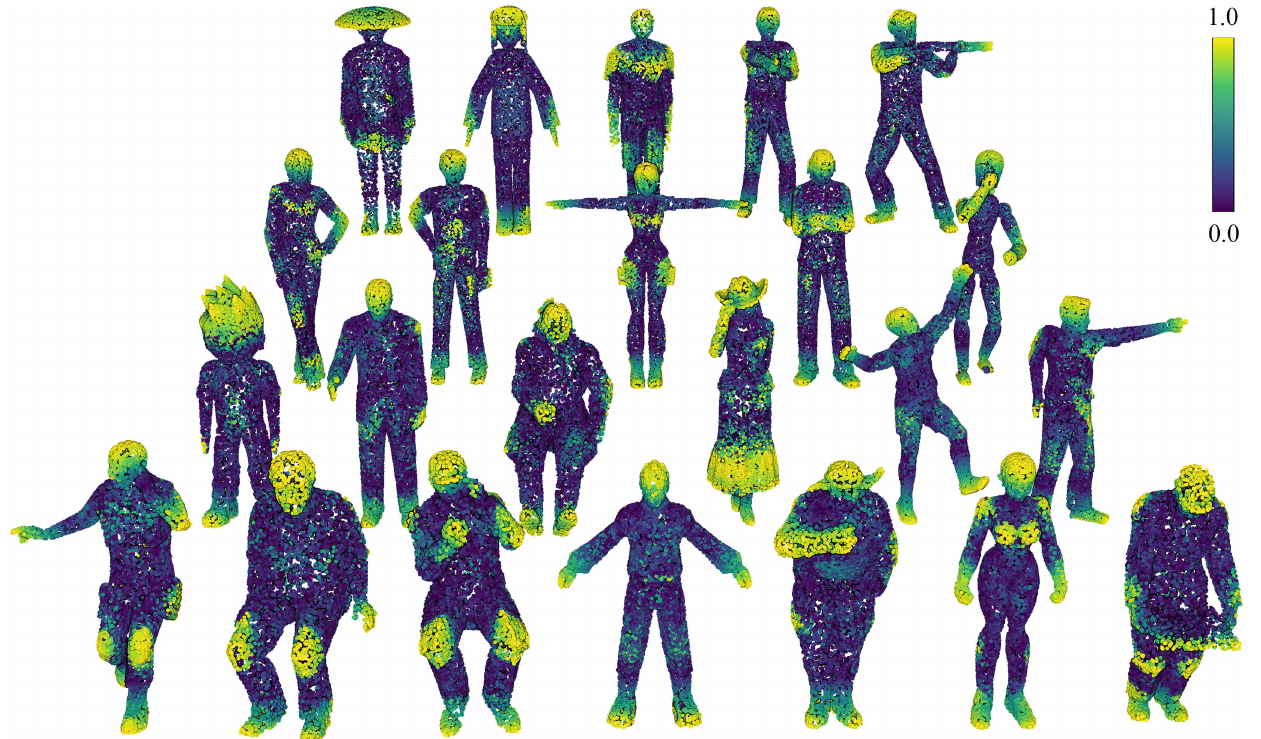
Figure 7. Visualization of one (manually chosen) dimension of the implicit features for the person category from the ModelNet dataset [23]. With this dimension of implicit features, the same prominent body parts are highlighted by the brighter color regardless of their